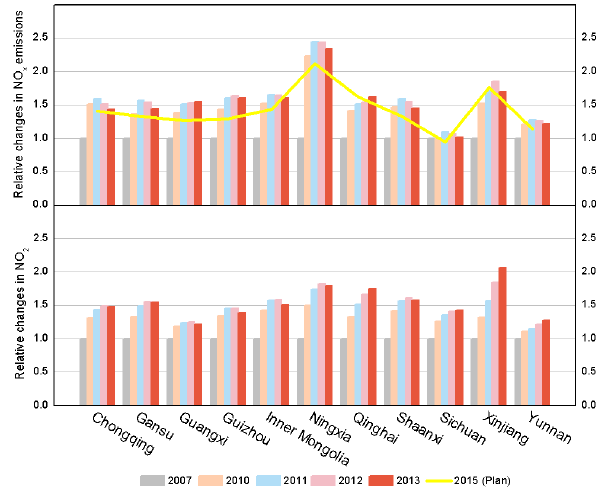
Figure 7. Relative Changes in OMI NO 2 VCDs and NO x emissions in 2007 and 2010–2013 (relative to 2007). (Top) Chinese official provincial-level NO x emission inventory for 2007 and 2010–2013 as well as its targeted emissions for 2015. (Bottom) Annual mean OMI NO 2 levels in 2007 and